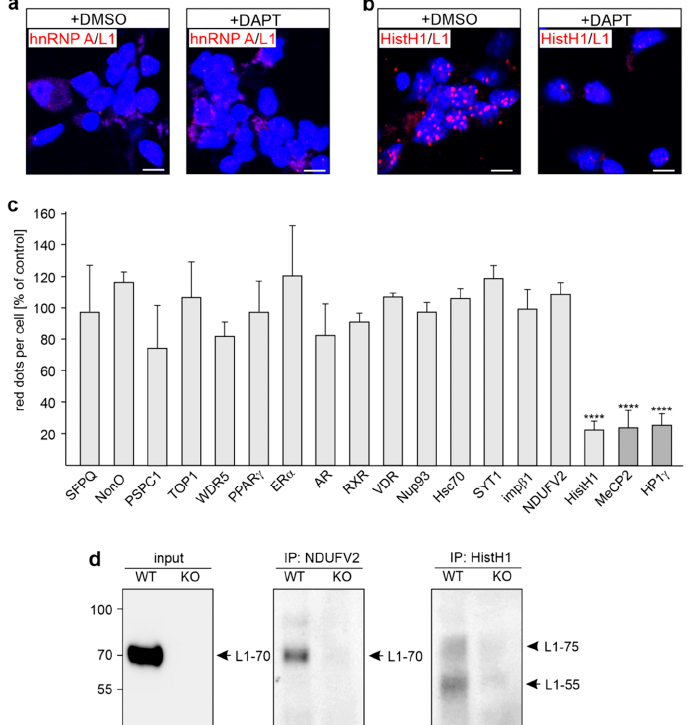
Figure 1. L1-55 interacts with MeCP2, HP1, and HistH1 but not with other verified or putative L1 binding partners in cultured cortical neurons. Neurons were treated with the vehicle dimethyl sul- foxide (DMSO) (+DMSO) or with the γ -secretase inhibitor DAPT and were then subjected to proxim- ity ligation with L1 antibodies and antibodies against NDUFV2, SFPQ, NonO, PSPC1, WDR5, TOP1, hnRNP A isoforms, HistH1, Nup93, Hsc70, SYT1, imp β 1, ER α , RXR, PPAR γ , AR, VDR, MeCP2, or HP1 γ . Nuclei are stained with DAPI (4 ′ ,6-diamidino-2-phenylindole). ( a , b ) Representative images of DMSO- and DAPT-treated neurons stained with mouse L1 antibody C-2 and a rabbit antibody against hnRNP A isoforms ( a ) or HistH1 ( b ) are shown. Scale bar: 10 µm. ( c ) The mean values + SD are from two independent experiments and show average numbers of red dots per cell after DAPT-treatment relative to control (values of vehicle control set to 100%) (**** p < 0.001; one-way ANOVA with Dunn’s multiple comparison test). Values obtained for proteins known to bind to L1-55 served as positive controls and are marked in dark gray. ( d ) Non-nuclear fractions from wild-type (WT) and L1-deficient (KO) mice were used for immunoprecipitation with mouse HistH1 or NDUFV2 antibodies immobilized to Protein G. Fractions (input) and immunoprecipitates (IP) were subjected to Western blot analysis with L1 antibody C-2. Arrows indicate L1-55 and L1-70, and the arrowhead indicates an unknown L1 band of approximately 75 kDa. Since recombinant SFPQ, NonO, PSPC1, and NDUFV2 bind to L1-ICD in ELISA [17,28], we performed competition ELISA with the KDET peptide to analyze whether binding of these proteins to L1-ICD is mediated by KDET. As a negative control, a peptide with a disrupted KDET motif was used. Disruption of the motif was achieved by the highly conserved substitution of K, D, E, and T by Q, N, Q, and S, respectively. We preferred this QNQS control peptide with conservative amino acid substitutions over a control peptide with a scrambled KDET sequence, because non-conservative scrambling could affect the primary structure much more than conservative substitutions, e.g., when K are exchanged